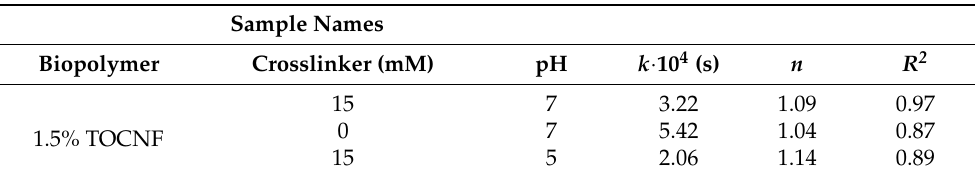
Figure 4. The amount of released bacteriophage ( M t / M ∞ , see Equation (2)) from 1.5% TOCNF hydrogels prepared in polyHIPE particles with different concentrations of Ca 2+ in release medium with a pH of 5 and 7 at 37 ◦ C. Table 1. Values of kinetics constant k , the diffusional exponent n and goodness of linear fit R 2 obtained from Figure 4.